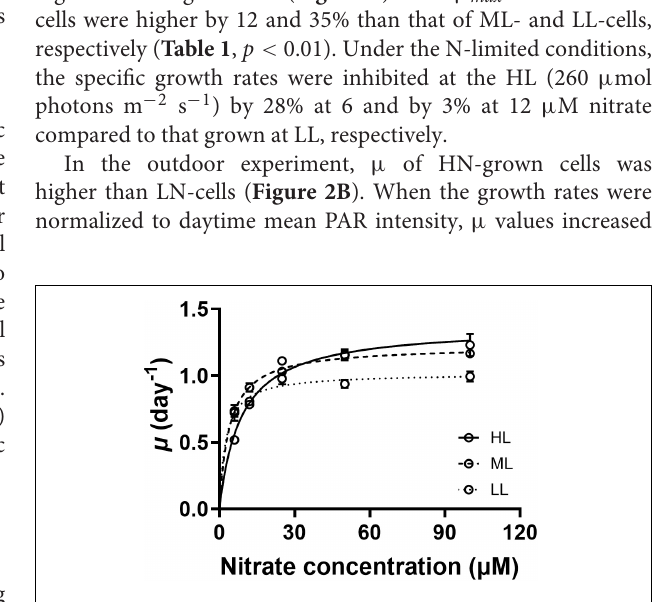
FIGURE 1 | The specific growth rates of Gephyrocapsa oceanica as a function of nitrate concentrations (6, 12, 25, 50, and 100 µ M) grown under constant light levels of 260 (HL, solid line), 115 (ML, broken line), and 50 µ mol photons m - 2 s - 1 (LL, dotted line), respectively. The values are the means ± SD of triplicate